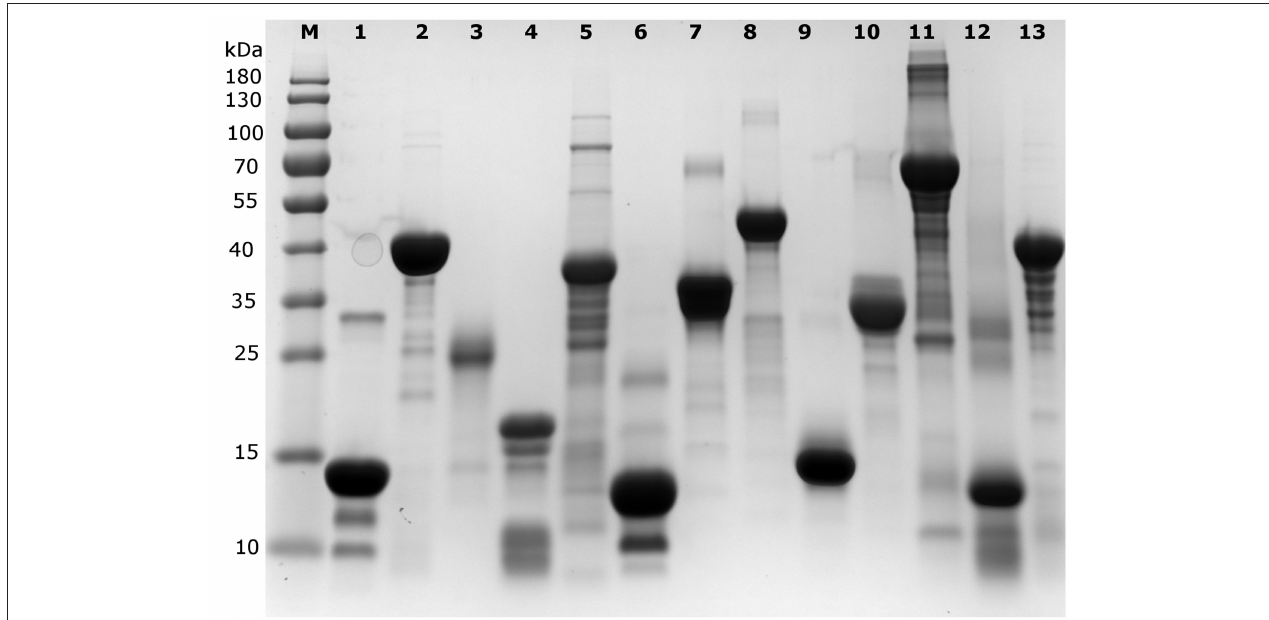
FIGURE 1 | SDS-PAGE analysis of the proteins used in the different quantification assays. An overloaded gel shows only minor impurities in the proteins obtained from a commercial source or purified in house (cf. Table 1 ). M indicates the lane with marker proteins and their corresponding apparent molecular weight is indicated on the left (in kDa). The protein samples per lane are as follows: 1: Hint1, 2: ID5, 3: hCSD1, 4: α -synuclein, 5: AF1, 6: DBD, 7: ERD14, 8: ERD10, 9: EM, 10: β -casein, 11: BSA, 12: hemoglobin, 13: ID1.